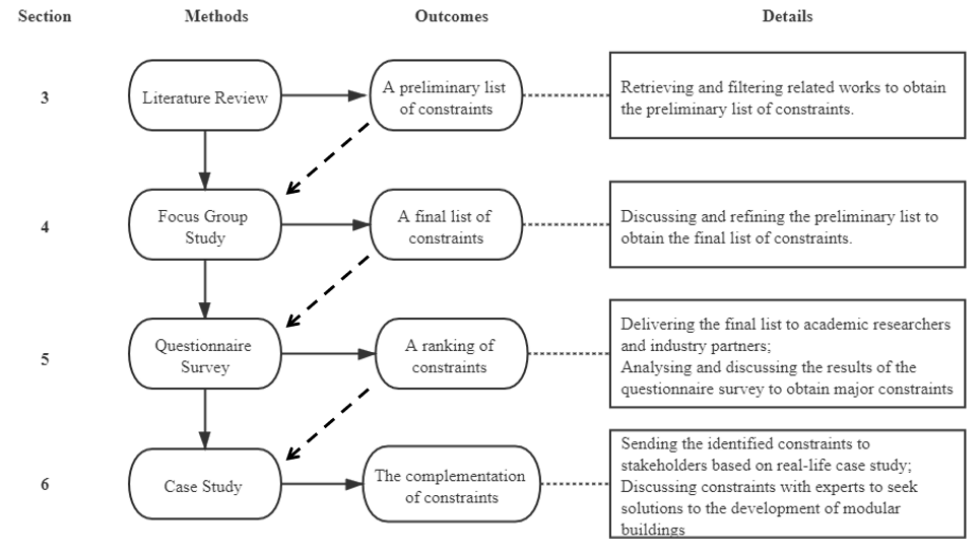
Figure 1. Research design flow.